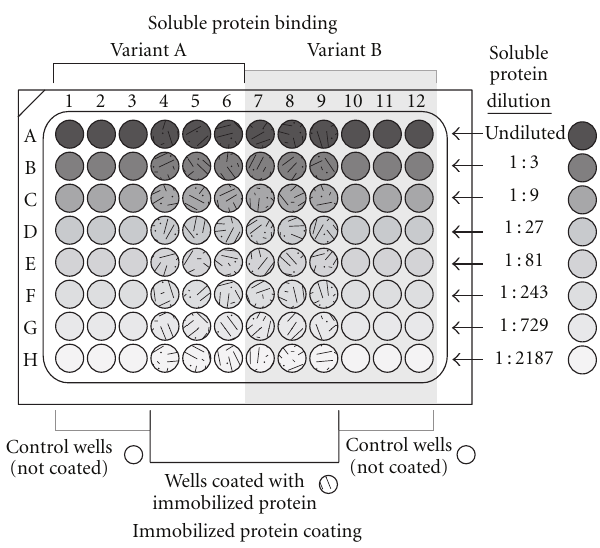
Figure 2: Representative design of a 96-well microtitering plate assay for binary binding consisting of an immobilized protein incubated with two variant soluble interacting proteins in 8 serial concentrations of triplicate wells. Immobilized protein is equally and maximally coated in the experimental wells, rows A to H and columns 4 to 9. Columns 1 to 3 and 10 to 12 are left uncoated (incubated with coating bu ff er only) as controls. Following coating all wells are blocked, and the wells in columns 1 to 6 are incubated with serial dilutions, one dilution per row, of one of the soluble proteins, and wells in columns 7 to 12 are incubated with serial dilutions of the other soluble protein variant. All wells are then processed uniformly for ELISA